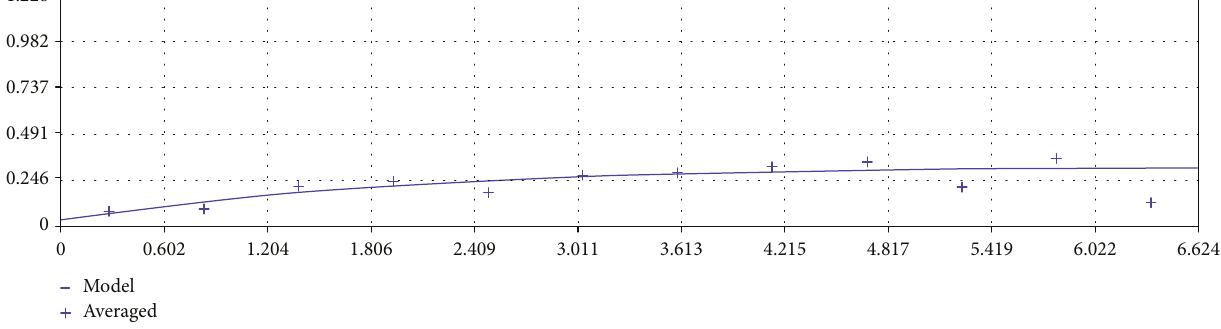
Figure 5: Experimental variogram (plotted points) and fi tted model (solid line) of the calcium values in the spring waters of Mt.